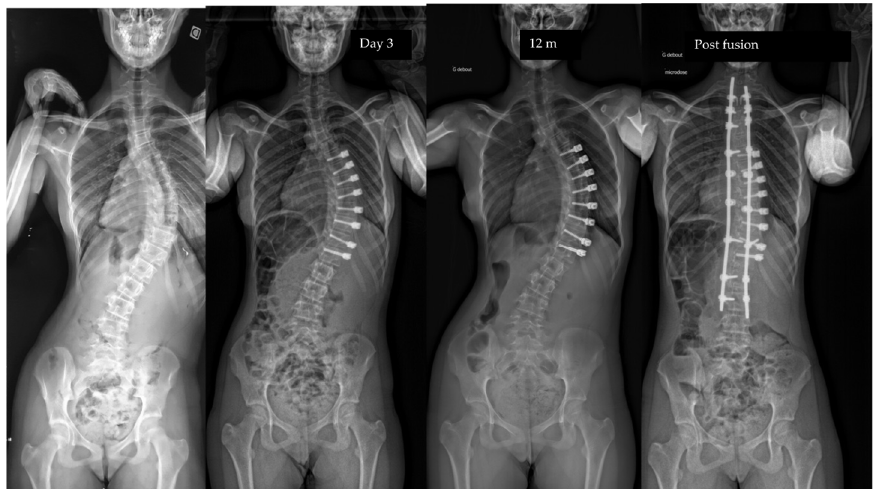
Figure 7. Radiographs of a 12-year-old patient, Risser 0, with a main long thoracic curve (lower end